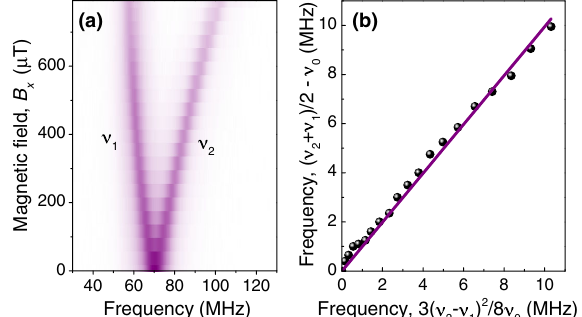
FIG. 6. (a) Evolution of the ODMR spectrum as a function of the perpendicular magnetic field B ⊥ ¼ B represent the quadratic shift ð ν 2 þ ν 1 Þ = 2 − ν 0 versus the Zeeman splitting in terms of 3 ð ν 2 − ν 1 Þ 2 = 8 ν 0 . Solid line is a linear fit to Eq. (D5) with a slope of 0 . 995 (cid:2) 0 . 01